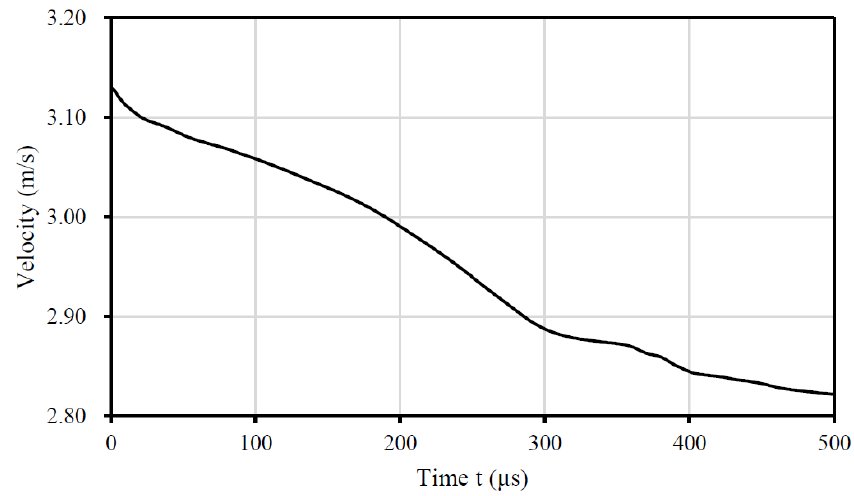
Figure 10. Vertical velocity of the projectile.